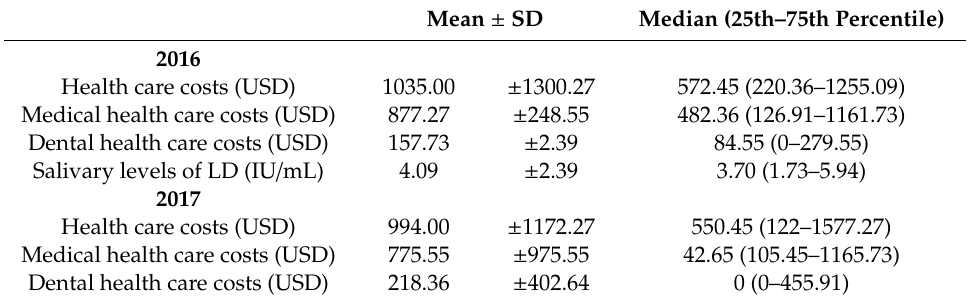
Table 1. Descriptive analysis of the health care costs and salivary levels of lactate dehydrogenase